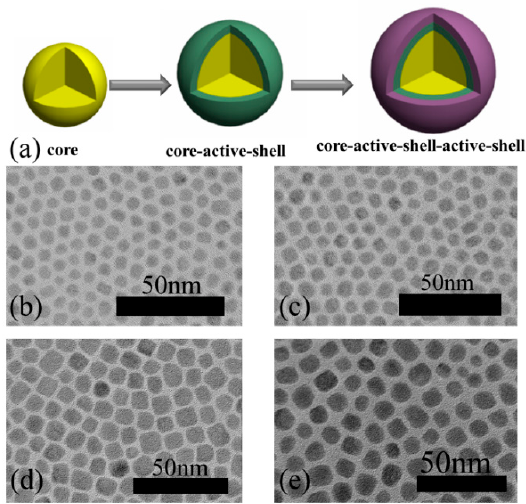
Figure 2. ( a ) Schematic illustration of BaLuF 5 core NPs, BaLuF 5 core-active-shell NPs and BaLuF 5 core-active-shell-active-shell NPs. TEM images of ( b ) BaLuF 5 :18%Yb 3+ ,2%Er 3+ core NPs; ( c ) BaLuF 5 :18%Yb 3+ ,2%Er 3+ ,2%Ce 3+ core NPs; ( d ) BaLuF 5 :18%Yb 3+ ,2%Er 3+ ,2%Ce 3+ @BaLuF 5 :5%Yb 3+ core-active-shell NPs; and ( e ) BaLuF 5 :18%Yb 3+ ,2%Er 3+ ,2%Ce 3+ @BaLuF 5 :5%Yb 3+ @BaLuF 5 :5%Yb 3+ core-active-shell-active-shell NPs.